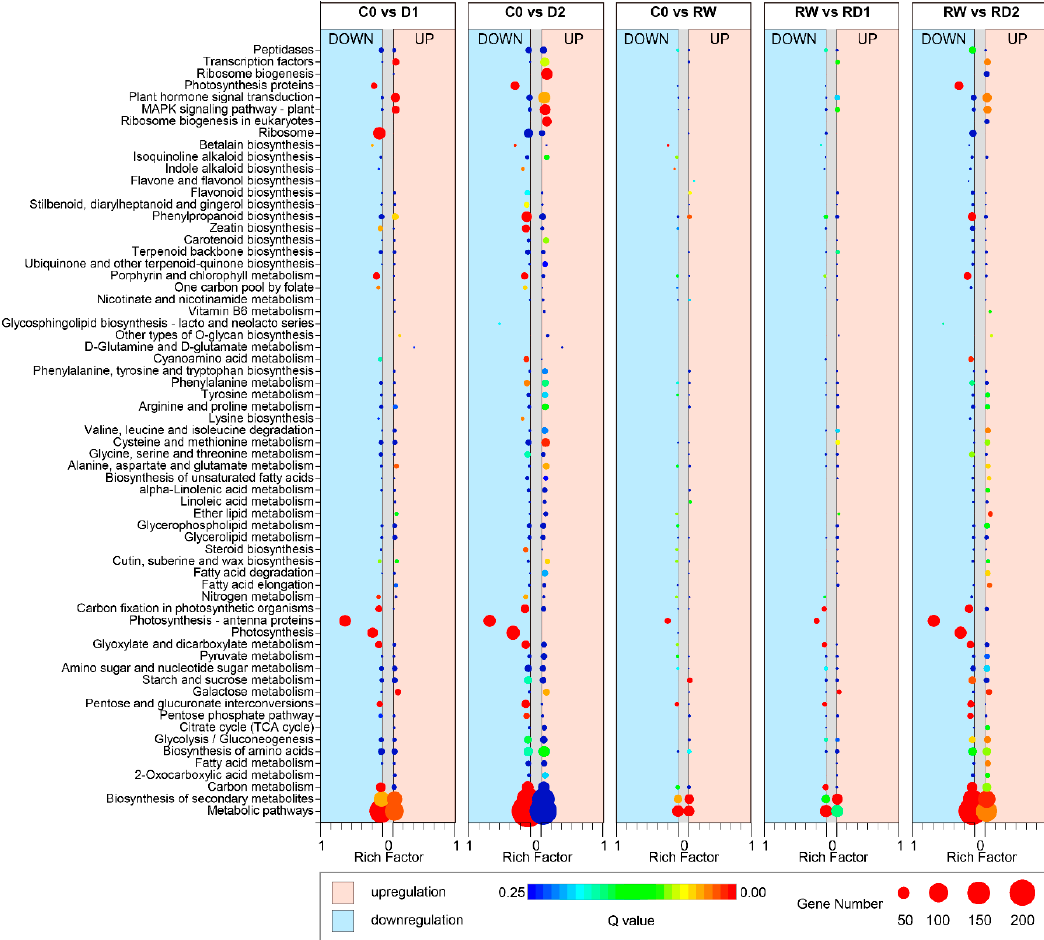
Figure 3. Kyoto Encyclopedia of Genes and Genomes (KEGG) enrichment of DEGs in response to drought and re-dehydration in potato. The area of bubbles indicates the number of enriched DEGs, while the color of bubbles indicates Q-value. Those on the light pink background are the enriched upregulated DEGs; the downregulated DEGs are on the light blue background.